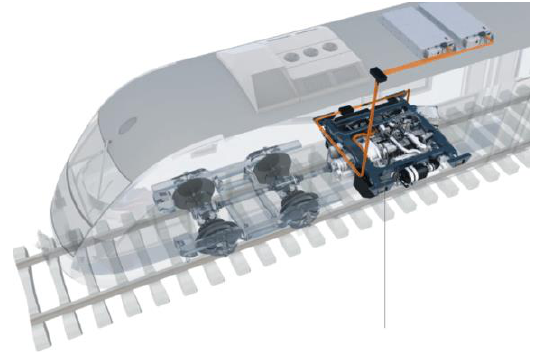
Fig. 8. Powerpack from the MTU company designed for railbus applica- tions [20]